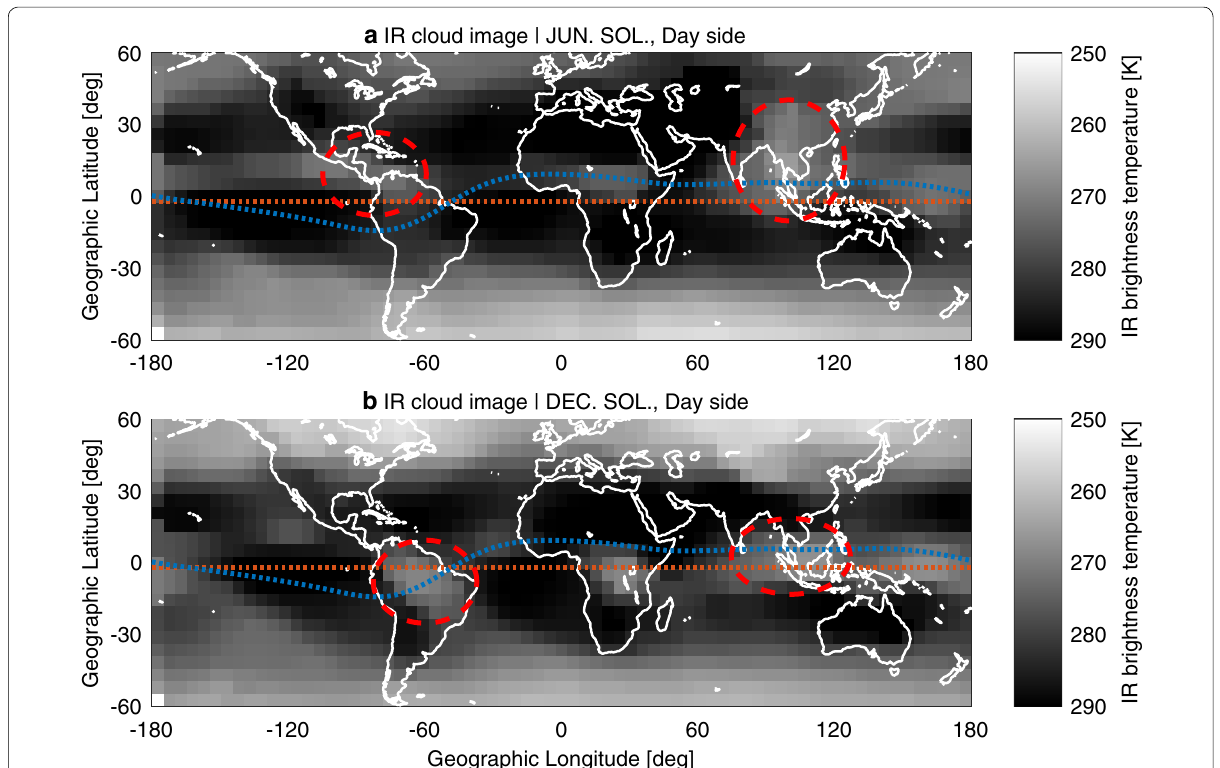
Fig. 16 Seasonal dependence of the average infrared brightness temperature on the day side. a June solstice and b December solstice. The red and blue dotted lines indicate the geographic and dip equator,